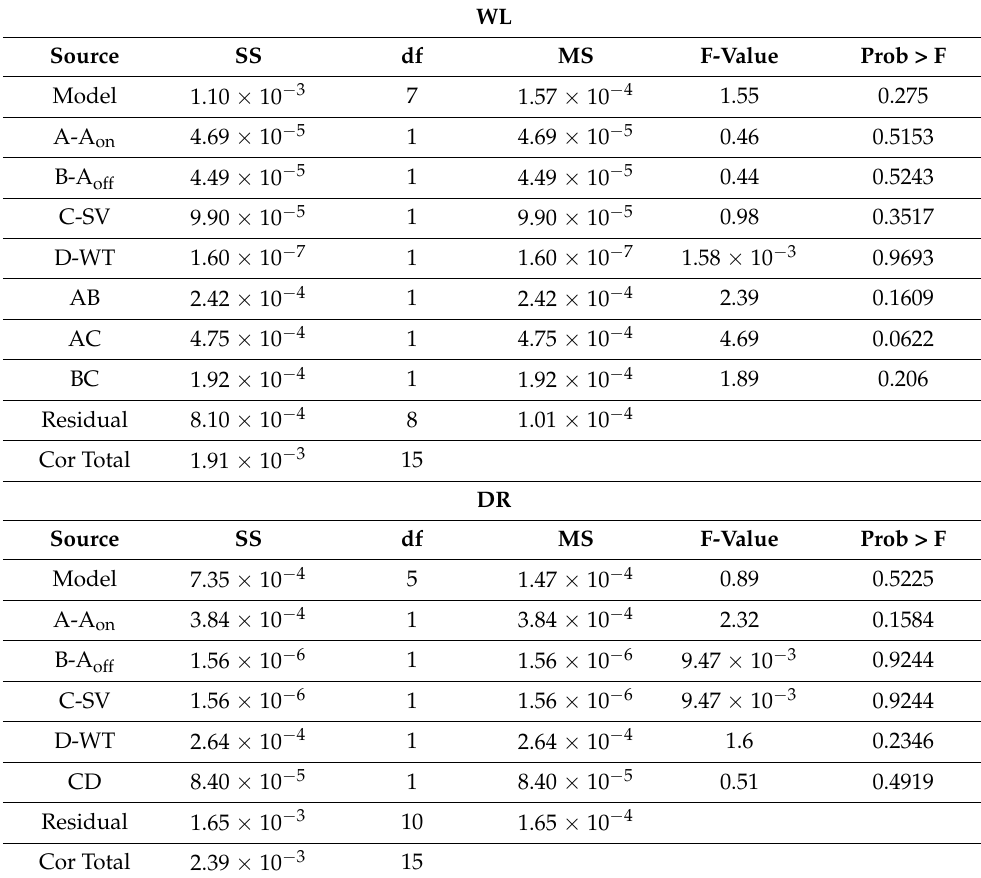
Table 8. ANOVA for WL and